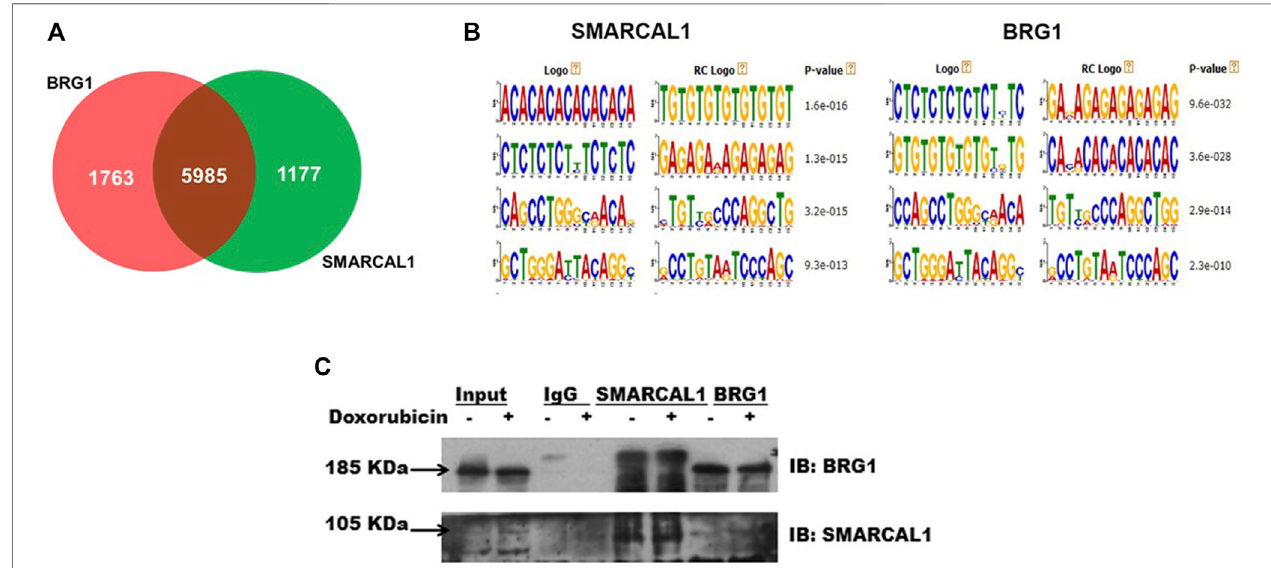
FIGURE 1 | SMARCAL1 and BRG1 co-immunoprecipitate, in the absence and presence of DNA damage: Genome-wide occupancy of SMARCAL1 and BRG1 identi fi edbyChIP-seqanalysis (A) .Venndiagramshowingtheintersectionofthemajorityofgenes (B) .IdenticalDNAmotifsoccupiedbySMARCAL1andBRG1 (C) Co- immunoprecipitationexperiments wereperformed withantiSMARCAL1andanti-BRG1 inuntreatedandtreatedproteinsampleswith2 μ Mdoxorubicinfor10 min. The pull-down protein samples were probed for both proteins. IgG antibody was used for negative control. HeLa cells were used for the experiments. The experiment was performed using two independent biological samples and a representative blot has been included.